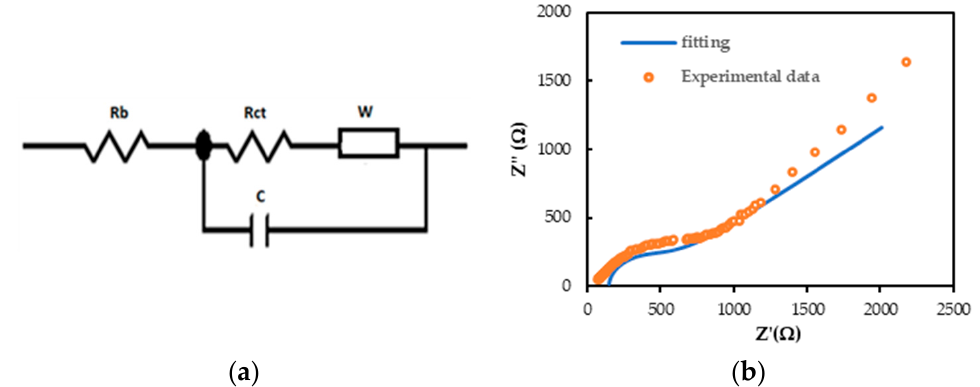
Figure 7. ( a ) The electrical equivalent circuit model that best fits the experimental data; ( b ) fitting of the experimental data of SX ‐ LMNCO ‐ 811 with the EEC model.